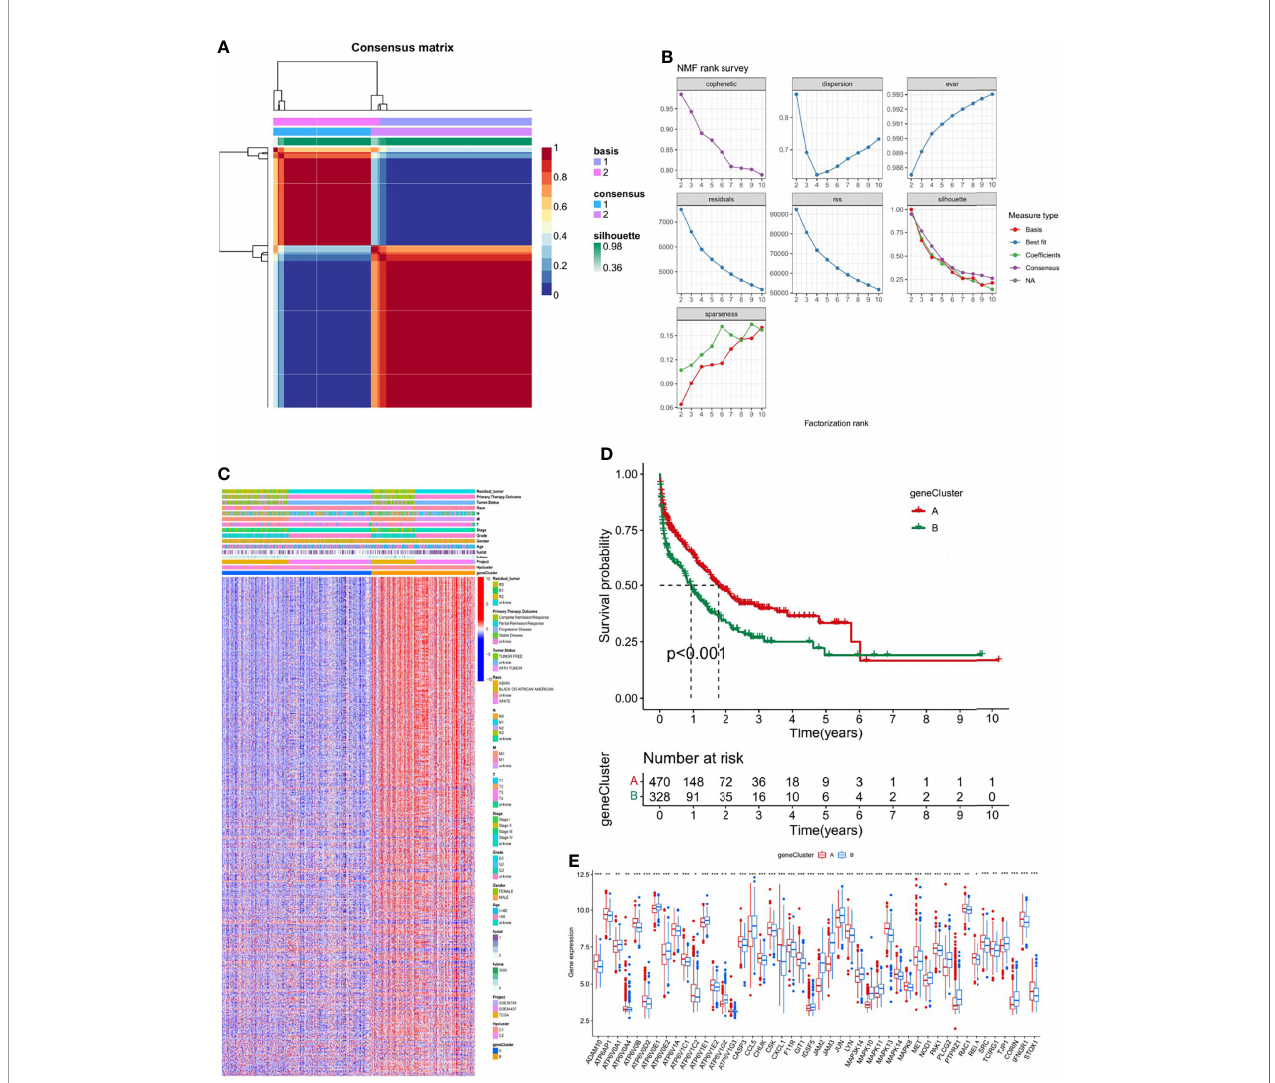
FIGURE 5 | Identi fi cation of gene subtypes based on DEGs. (A) NMF analysis on the 706 DEGs. (B) NMF rank survey conducted on the DEGs. (C) Heatmap presenting the differentiation of the clinicopathological characteristics of the two gene clusters. (D) Survival analysis of the two gene clusters. (E) Gene expression analysis of the two gene clusters. ns, no signi fi cance, p ≥ 0.05; *, p<0.05; **, p<0.01; ***,